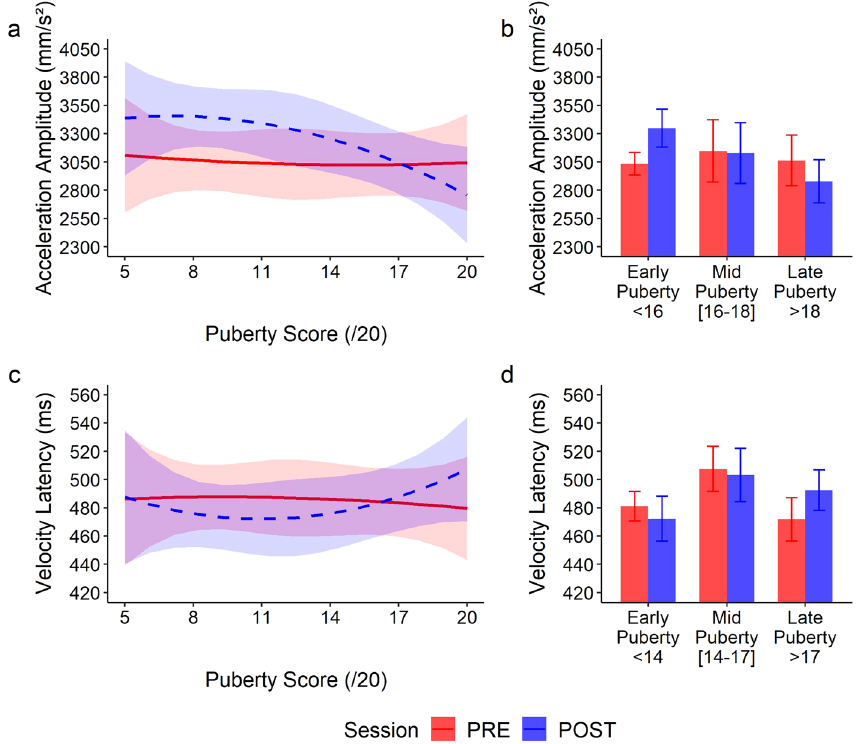
Figure 3. Evolution of the kinematics of the Reaching component of the movement before (solid red) and after (dashed blue) tool use, as a function of the puberty score. Panels ( a ) and ( c ) are representative illustrations of the polynomial fit of the data for the acceleration amplitude ( a ) and the velocity latency ( c ), with the 95% confidence interval indicated by colored areas. Puberty score did not affect the initial movement kinematics (PRE: solid red) but changed participants’ behavior after tool use (POST: dashed blue) as shown by significant interactions. ( a ) After tool-use early puberty participants displayed higher acceleration amplitude (blue line with respect to the red line); beyond mid puberty, participants reversed their kinematics patterns and displayed smaller peaks after tool use. ( c ) A pattern reversal was also observed for the latency of the wrist velocity, though opposite. For better visualization, panels ( b ) and ( d ) report three groups we computed for the same parameters based on the puberty score, the mid-puberty group being the one for which no significant modification was observed between PRE and POST in the model (cut-off scores differing for each parameter, see section “Crossing Point” below). The typical adult pattern (reduced peaks and increased latencies) emerges only in the late puberty stage, after the crossing point in the model. Error bars indicate the means ± 1